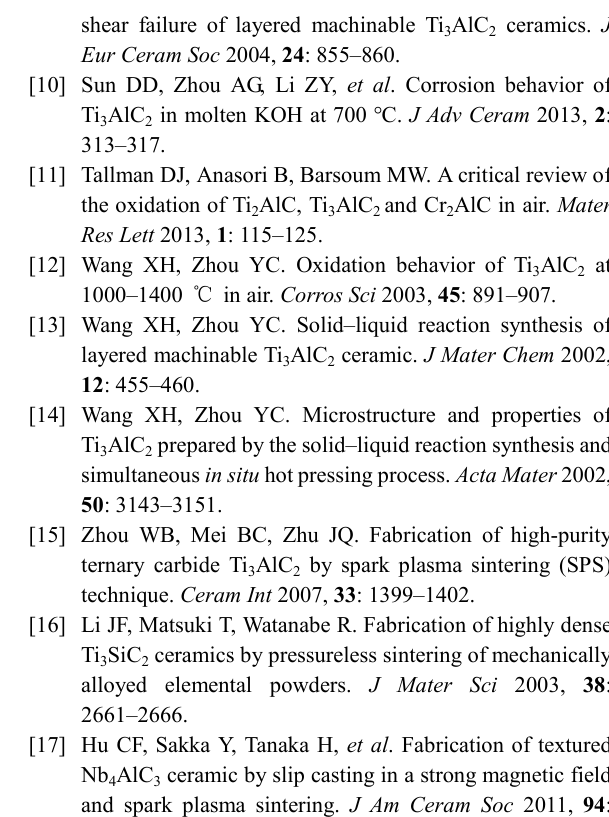
Fig. 13 (a, b) The typical SEM images on the fracture surfaces of Ti 3 AlC 2 sample sintered at 1450 ℃ with Al 4 C 3 embedding powder, (c) elemental mapping, and (d) EDS spectrum of the same area in